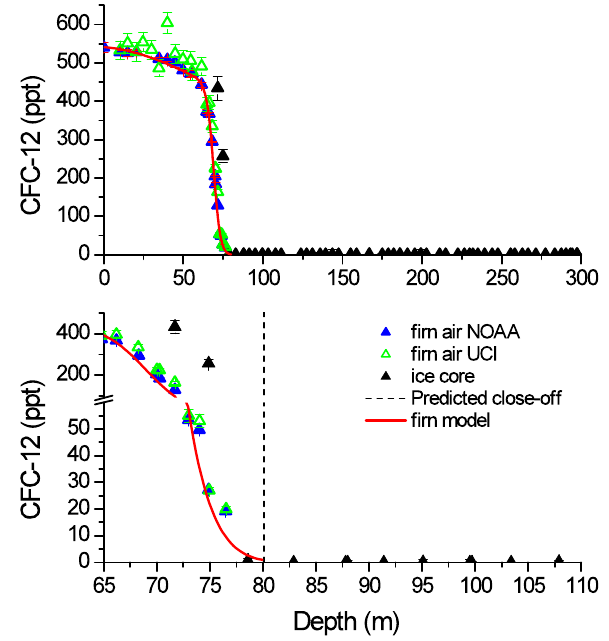
Fig. 1. Both panels – NOAA firn air data from the 2005 campaign (blue triangles) at WAIS-D, UCI firn air data (green triangles) for the same campaign, and UCI ice core data (black triangles) for the ice cores drilled the same year from a neighboring hole. The red line is the CFC-12 profile generated by the firn model. In the lower panel, the scales of x- and y-axes are adjusted to focus in on the firn-ice transition. The dashed line represents the full firn close-off depth as estimated by equation (1).